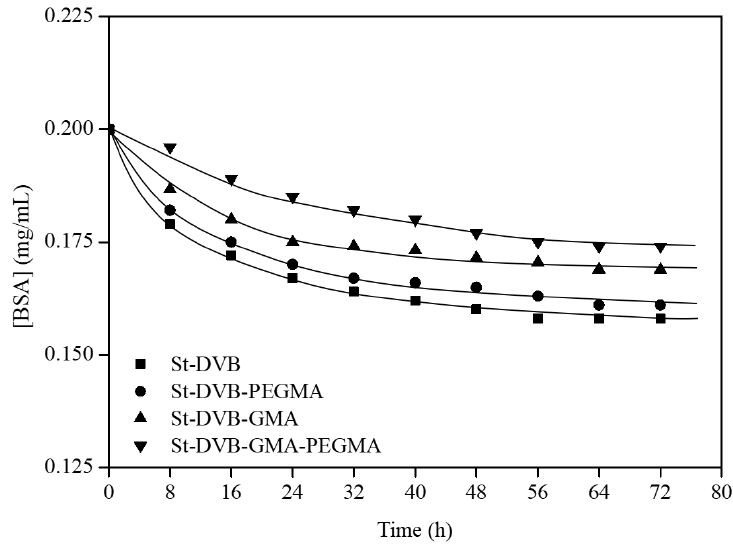
Figure 4. Kinetics of BSA immobilization in St-DVB pre-wetted particles. Wp = 2.5 g; T = 25 °C; t= 72 h and Fr = 8 mL/min.